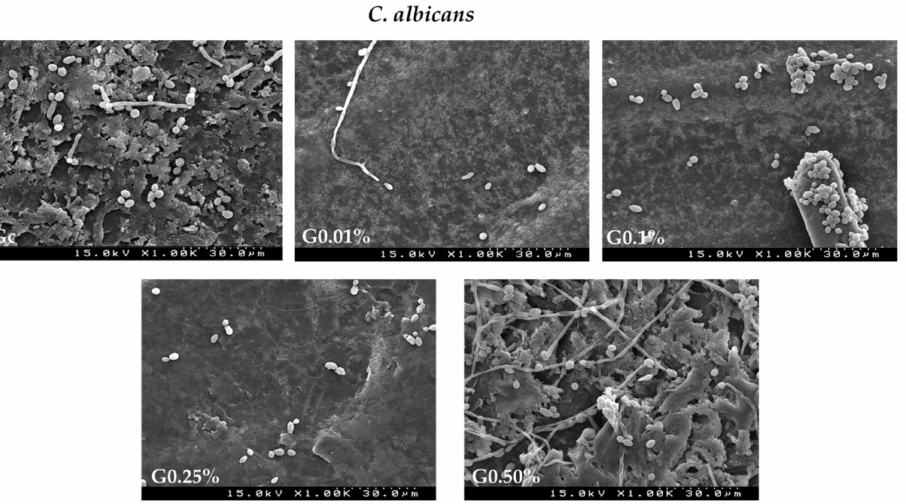
Figure 7. SEM images of graphene–PMMA specimens with different percentages of graphene incubated with C. albicans for 48 h. Number of cells visualized—Gc: 59; 0.01 wt%: 12; 0.1 wt%: 47; 0.25 wt%: 26; 0.5 wt%: 30.